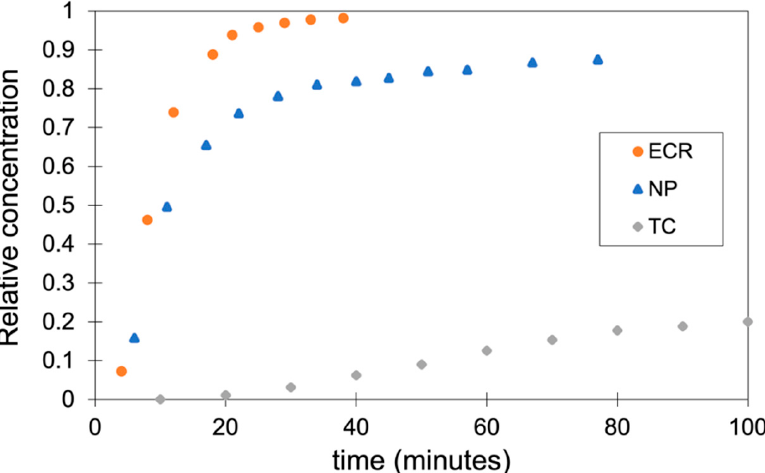
Figure 7. Breakthrough curves of ECR (orange), NP (blue) and TC (grey).